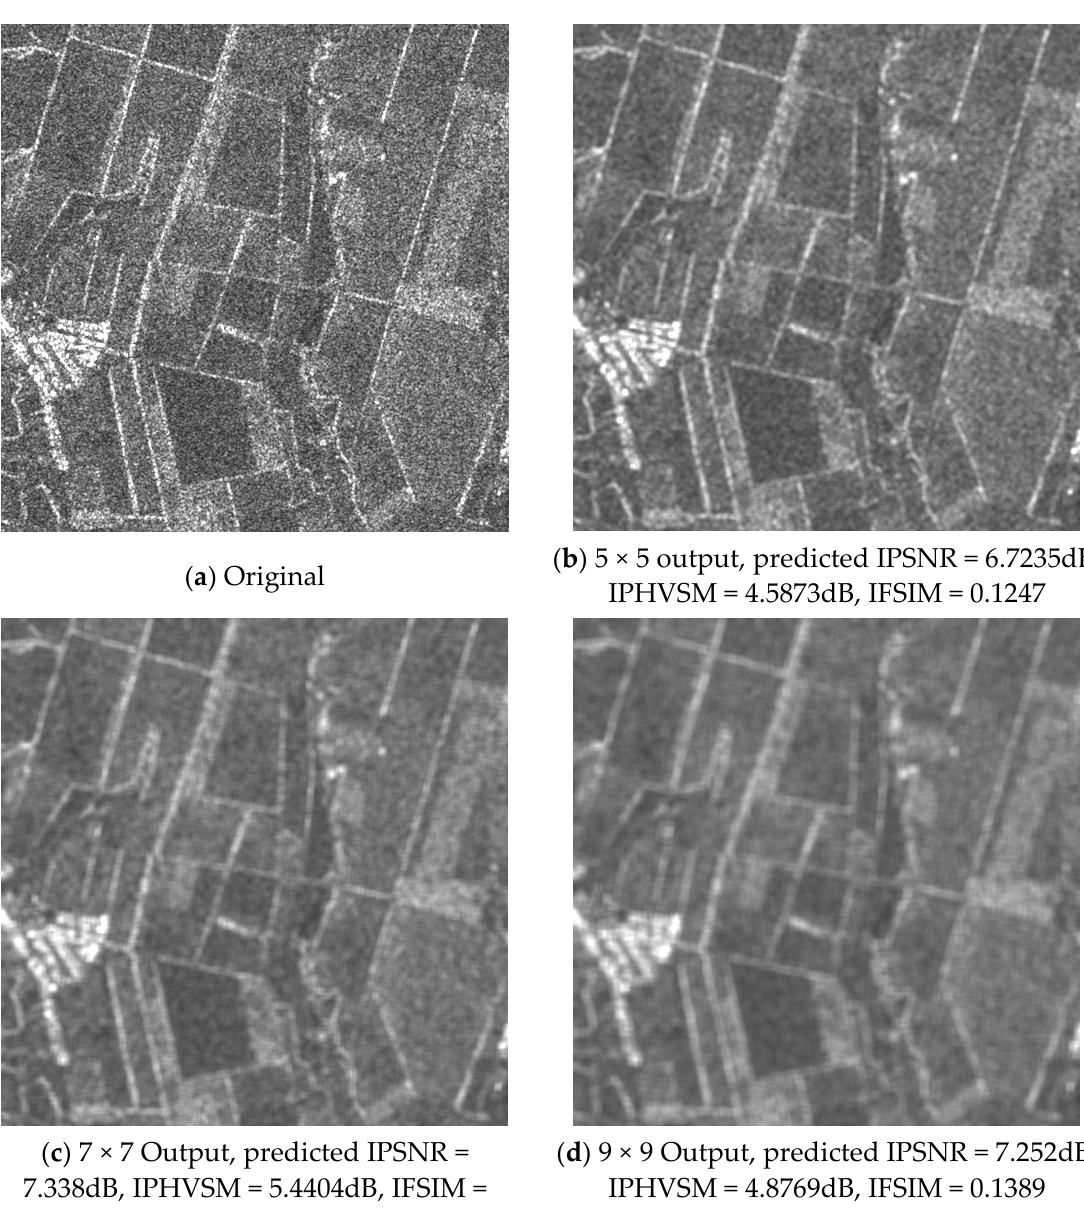
7.338dB, IPHVSM = 5.4404dB, IFSIM = 0.1478 Figure 20. The original Sentinel-1 image ( a ); and the outputs of the 5 × 5 ( b ); 7 × 7 ( c ); and 9 × 9 ( d ) Lee filters.